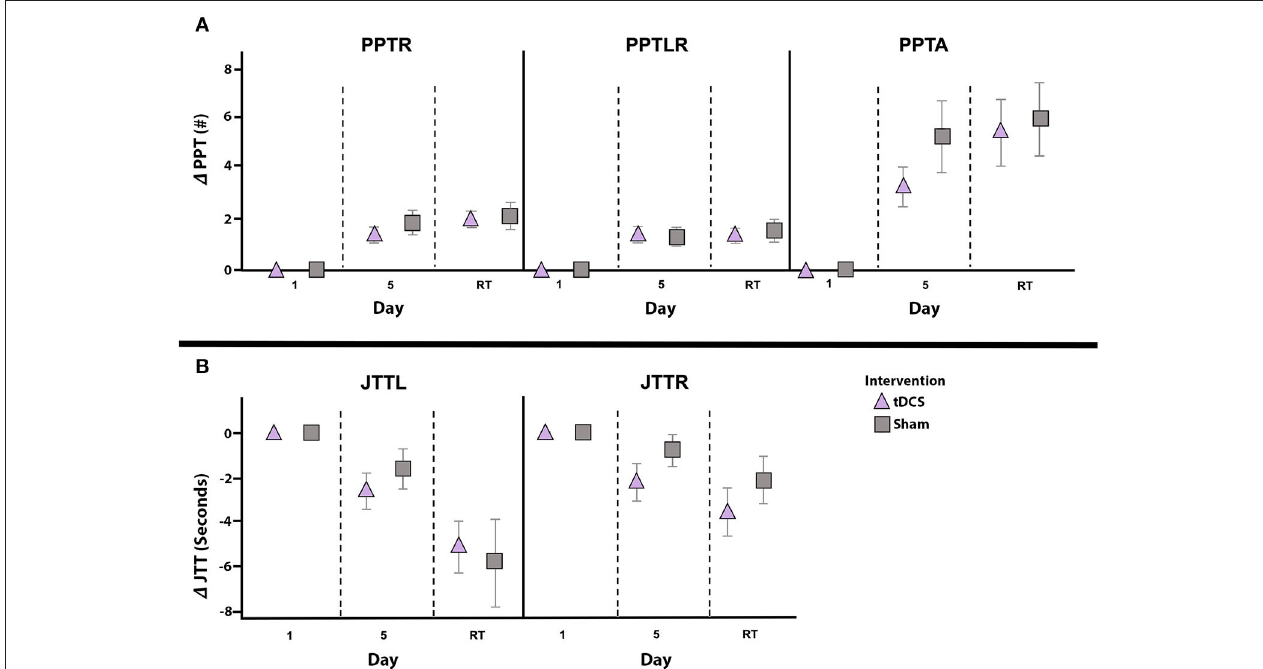
FIGURE 5 | Change in secondary outcomes measures by intervention group. Mean daily score change from baseline (y-axes) for PPT R , PPT LR , and PPT A (A) as well as JTT L and JTT R (B) , shown for the active (triangle) and sham (squares) groups. Error bars represent standard error. Independent of intervention group all scores significantly improved from baseline (day 1) to post-intervention testing on day 5, and from baseline to retention testing (RT) 6-weeks post-intervention. No between group differences in performance on any secondary measures were noted at any timepoint. Note that negative JTT scores indicate improved performance (i.e., reduction in completion time) and positive JTT scores indicate worse performance (i.e., increased time required to complete tasks). PPT L , Purdue Pegboard Test left-hand; PPT R , Purdue Pegboard Test right-hand; PPT LR , Purdue Pegboard Test bimanual; PPT A , Purdue Pegboard Test assembly; JTT L , Jebsen-Taylor Test left-hand; JTT R , Jebsen-Taylor Test